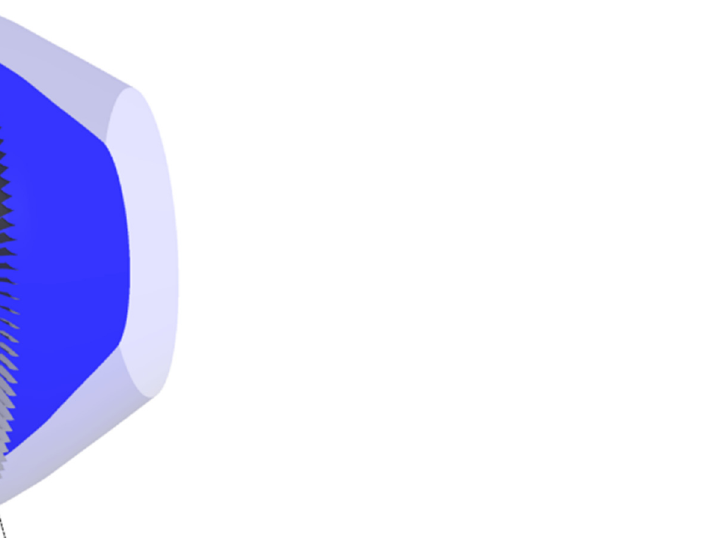
an extended period. tion takes place over